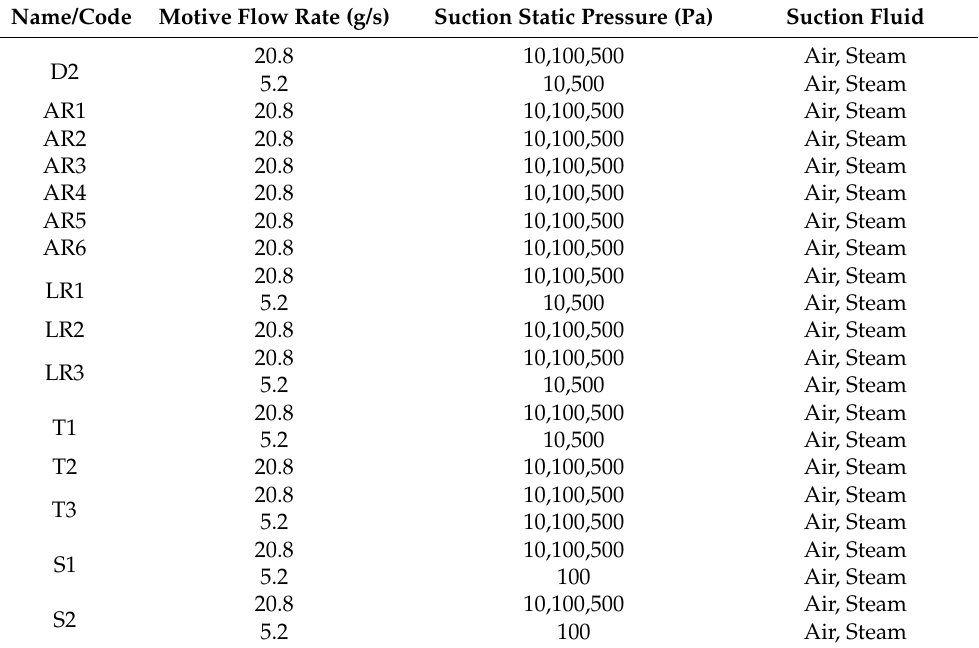
Table 4. Test matrix for parametric study. A total of 109 cases were studied. The AR code refers to the area ratio being varied while all other geometric parameters were held constant. Similarly, the LR, T, and S codes refer to varying the length ratio, throat diameter, and suction inlet diameter,